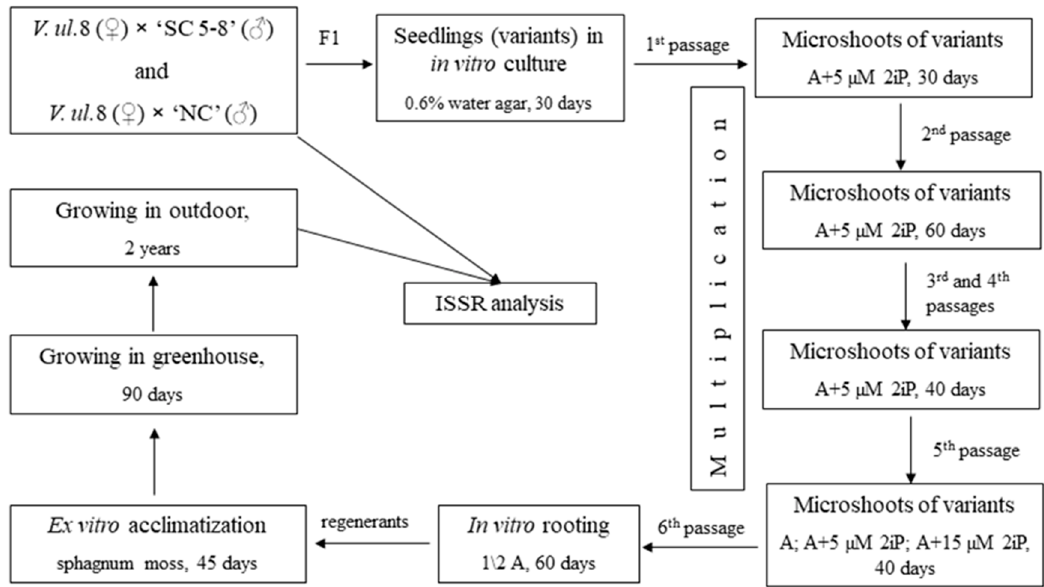
Figure 2. Schematic depiction of the experiment showing stages of in vitro propagation and ex vitro acclimatization, conditions and cultivation periods. Note: V.ul. 8— V. uliginosum , form No. 8; ‘NC’—( V. corymbosum × V. angustifolium ) ‘Northcountry’; ‘SC 5-8’—( V. corymbosum × V. angustifolium ) ‘SC 5-8’; A—Anderson nutrient medium.